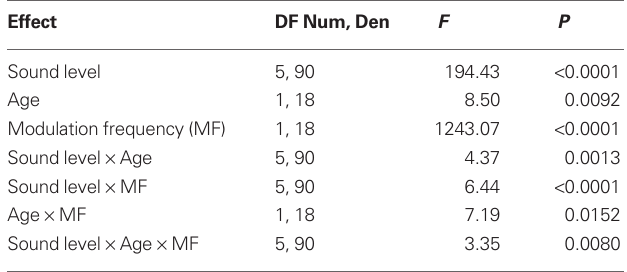
Table 2 | Tests of main effects of sound level (relative to click ABr threshold), age and modulation frequency, as well as all their interaction factors on AMFr amplitudes using repeated measures